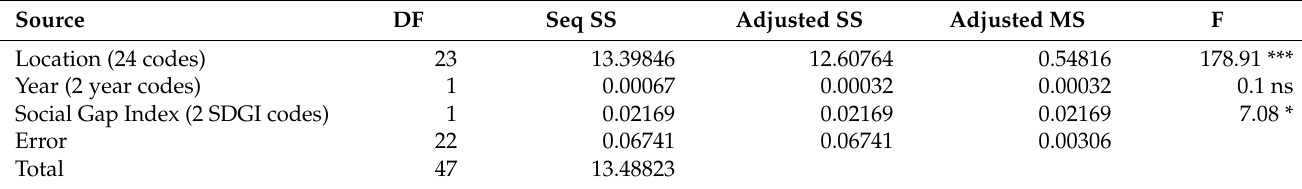
Table 6. Results of an ANOVA applied to the log-transformed radiance data in Table S5.